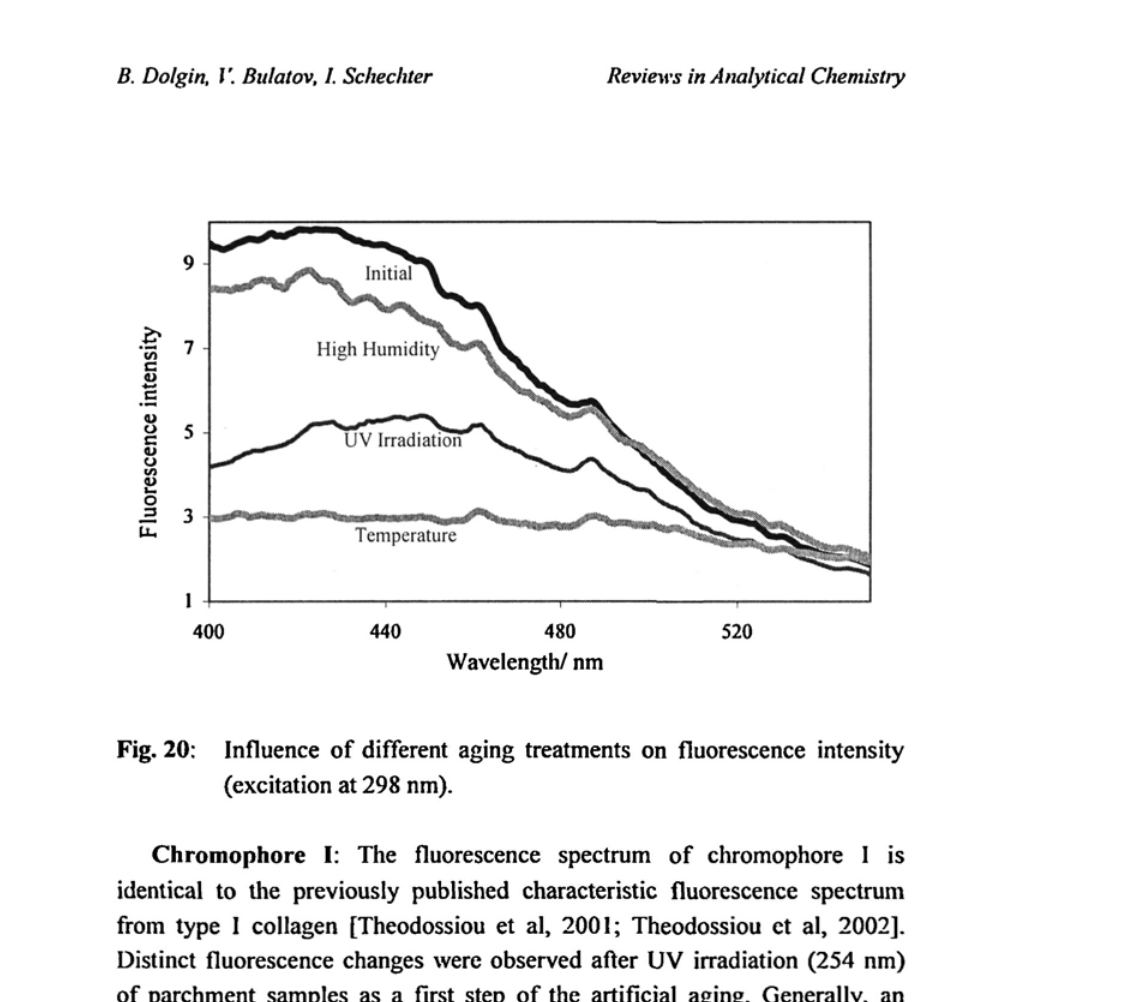
Fig. 20: Influence of different aging treatments on fluorescence intensity (excitation at 298